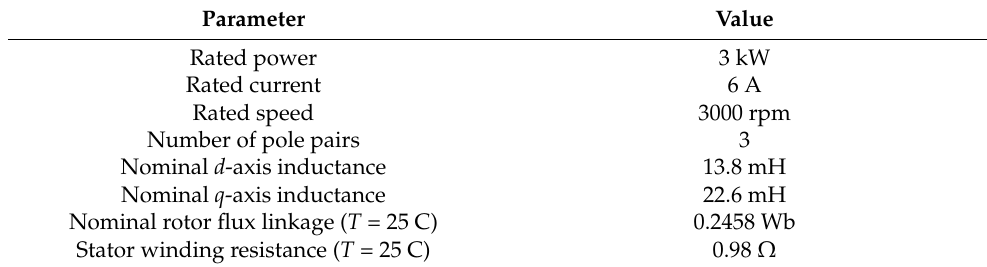
Figure 3. PMSM test rig. ( a ) Inverter and Speedgoat controller. ( b ) PMSM and load machine. Table 1. Design parameters of PMSM.